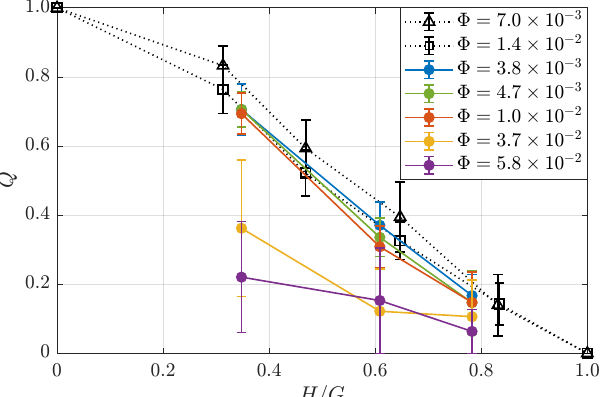
Figure 8. Permeability factor Q calculated using Equation (2) with respect to the normalized obstacle height H / G for liquid fractions Φ = 3.8 × 10 − 3 (purple), 4.7 × 10 − 3 (yellow), 1.0 × 10 − 2 (red), 3.7 × 10 − 2 (green) and 5.8 × 10 − 2 (blue) and the data from [24] for Φ = 7.0 × 10 − 3 (black triangles) and 1.4 × 10 − 2 (black